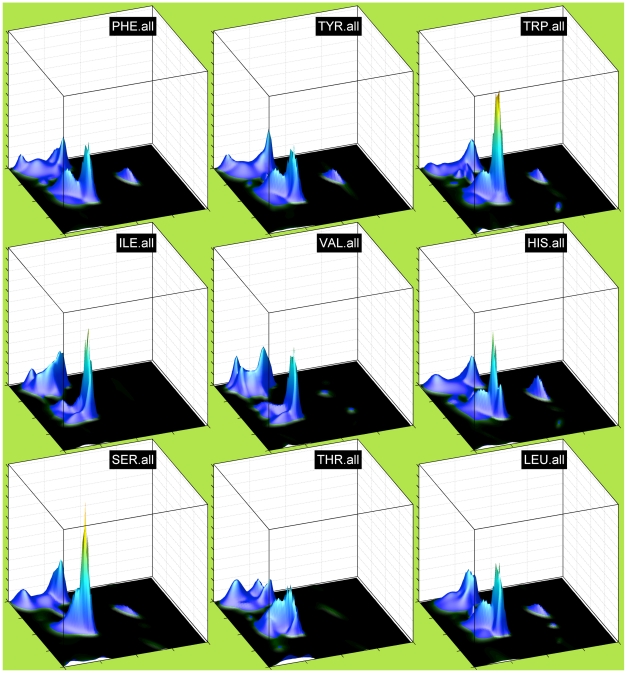
Neighbor-independent Ramachandran distributions for remaining 9 amino acid types (continued from Figure 1).For axis information, see caption to Figure 1.